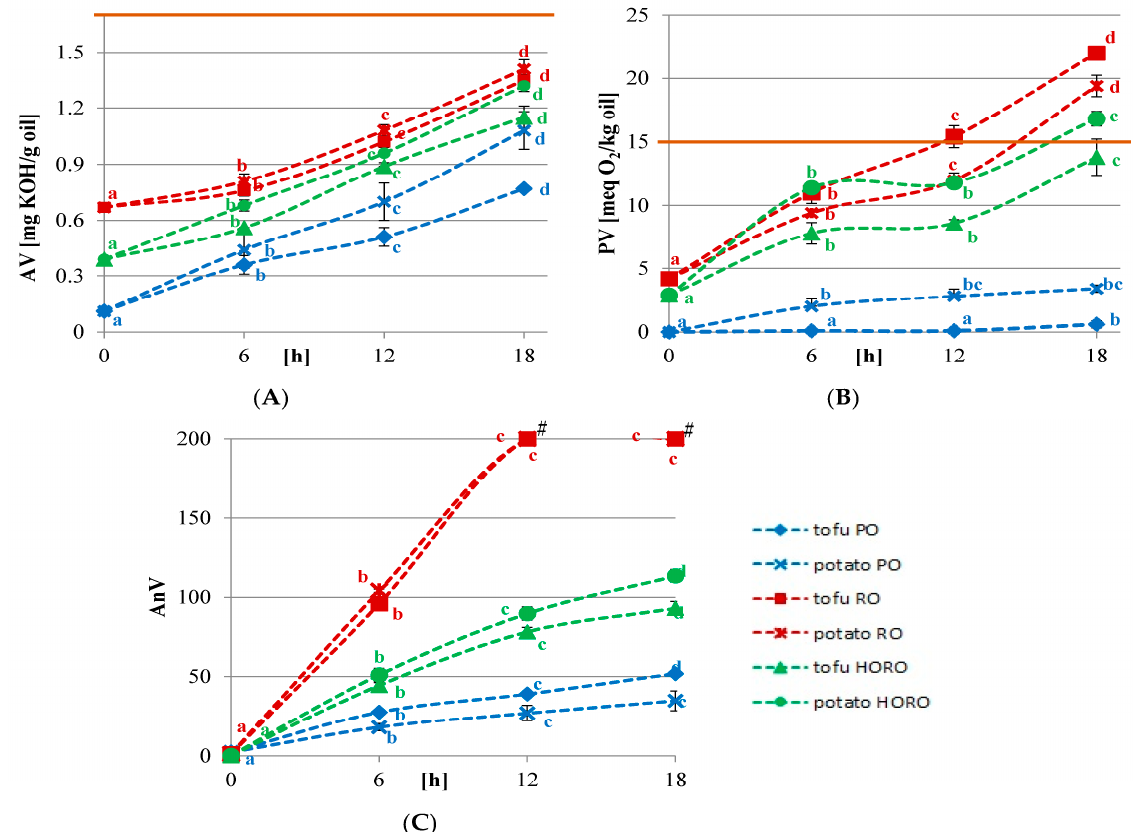
Figure 1. Changes of ( A ) acid values [mg KOH/g oil]; ( B ) peroxide values [meq O 2 /kg oil]; ( C ) p -anisidine values of tested oils during deep frying of tofu or potatoes. PO—palm olein; RO—cold pressed rapeseed oil; HORO—cold pressed high oleic rapeseed oil. # p -anisidine values above limit of quantification (>200). The values for the specific oil and type of fried product with different letters (a, b, c, d) are significantly different ( p < 0.05).